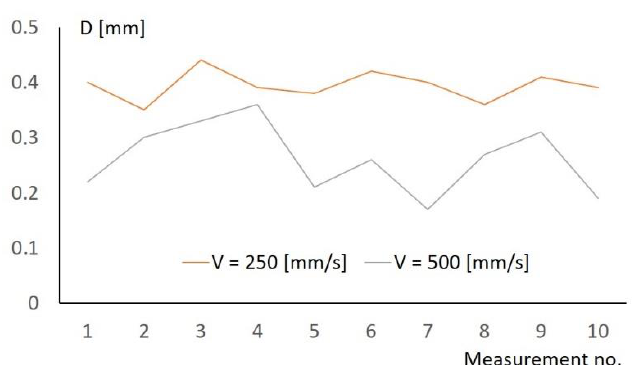
Figure 11. Examination of the stability process for two speed values.